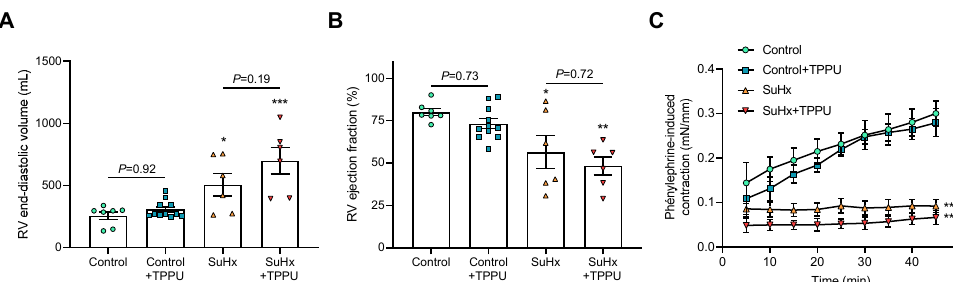
Figure 4. Values of RV end-diastolic volume ( A ), RV ejection fraction ( B ), and phenylephrine-induced pulmonary artery constriction ( C ) obtained in normoxic control rats and in rats receiving Sugen 5416 associated with 3-week hypoxia (SuHx) treated with vehicle or with the soluble epoxide hydrolase inhibitor TPPU. Data were obtained from different series of animals than those presented in Figures 1–3. * p < 0.05, ** p < 0.01, and *** p < 0.001 vs. corresponding control rats.